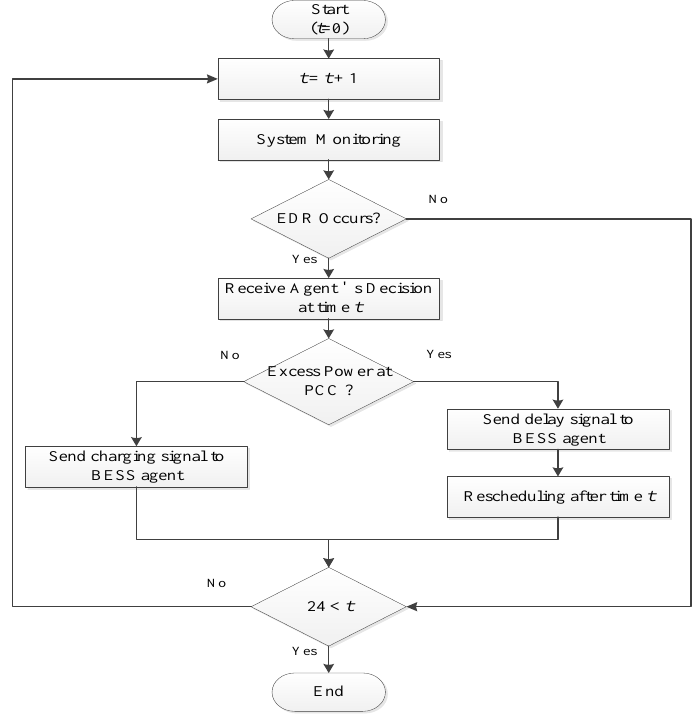
Figure 7. Flow chart of microgrid central controller (MGCC) operation algorithm.